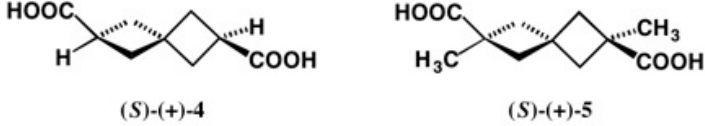
Figure 5. Absolute configurations of Fecht acid (+)- 4 and analog (+)- 5 .